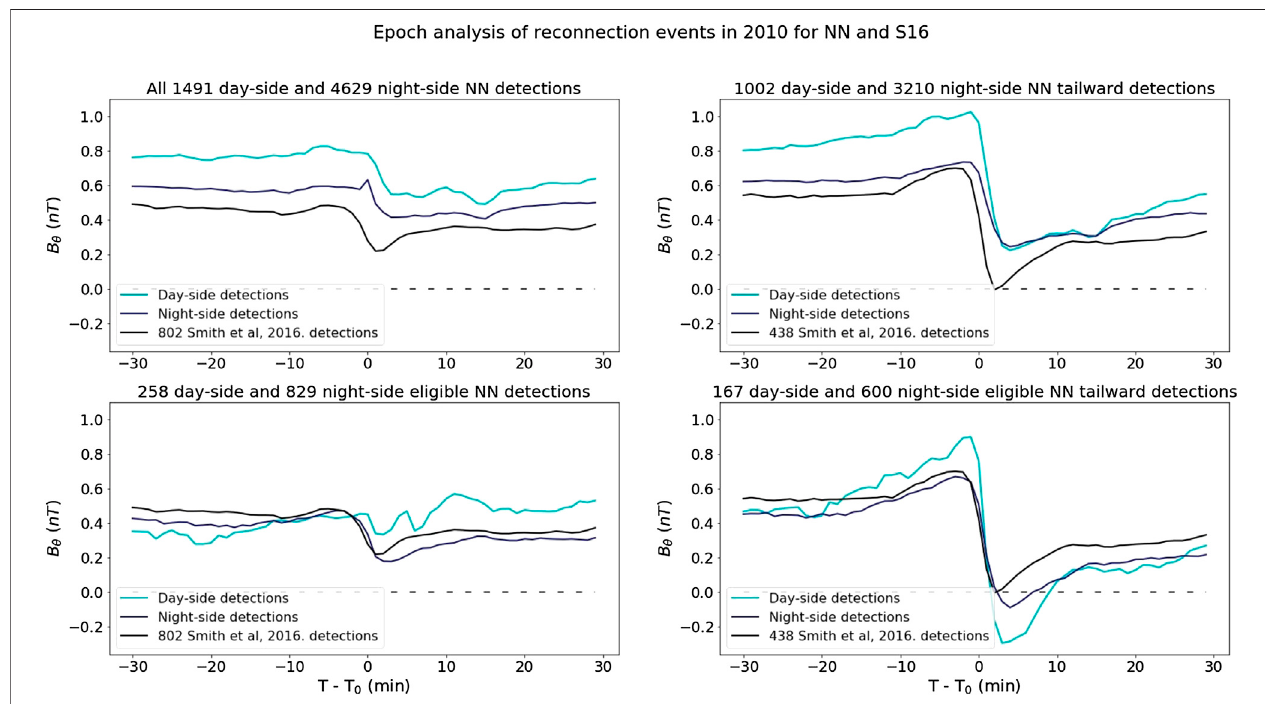
FIGURE 9 | Epoch analysis of all 2010 events (top left), tailward events (top right), all 2010 events that meet the S16 criteria (bottom left), and meet the S16 criteria while also being tailward (bottom right) identi fi ed by the NN. Identi fi cations are split onto the day-side (light blue) and night-side (dark blue) and are compared to the average of events from the S16 for 2010 (left) and tailward.